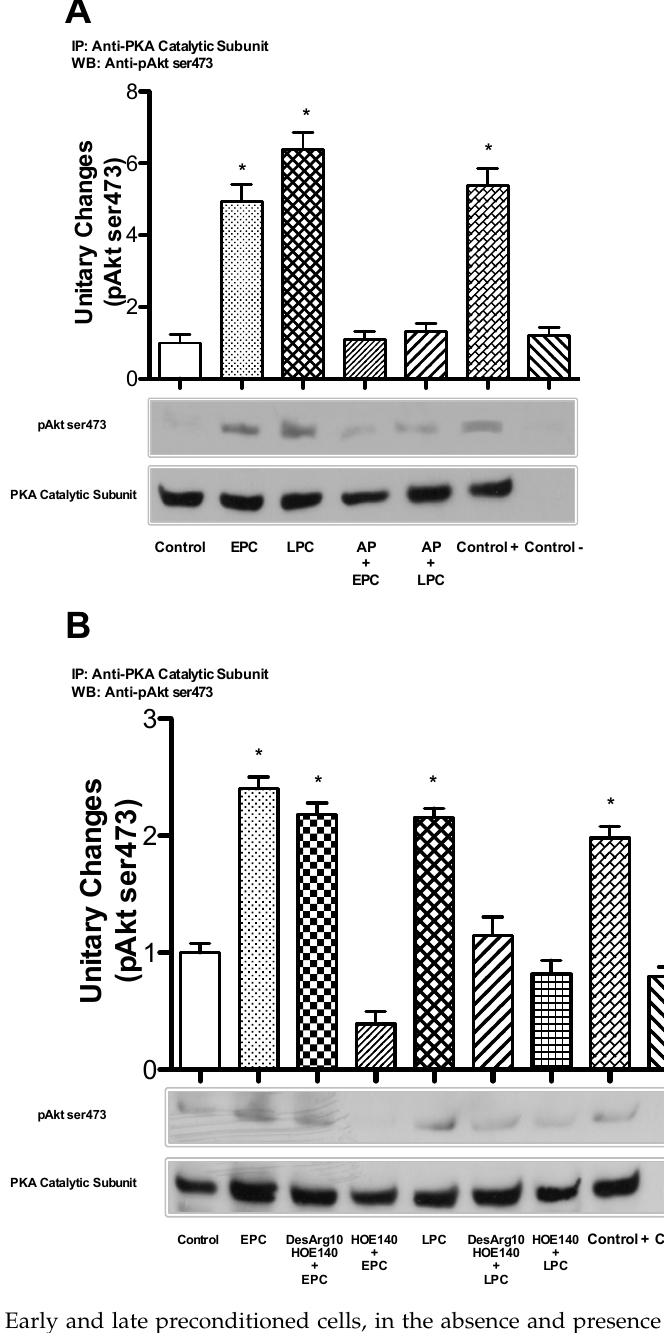
Figure 6. ( A ) Early and late preconditioned cells, in the absence and presence of aprotinin (KLK1 selective inhibitor), were harvested, immunoprecipitated with an antibody recognizing the catalytic